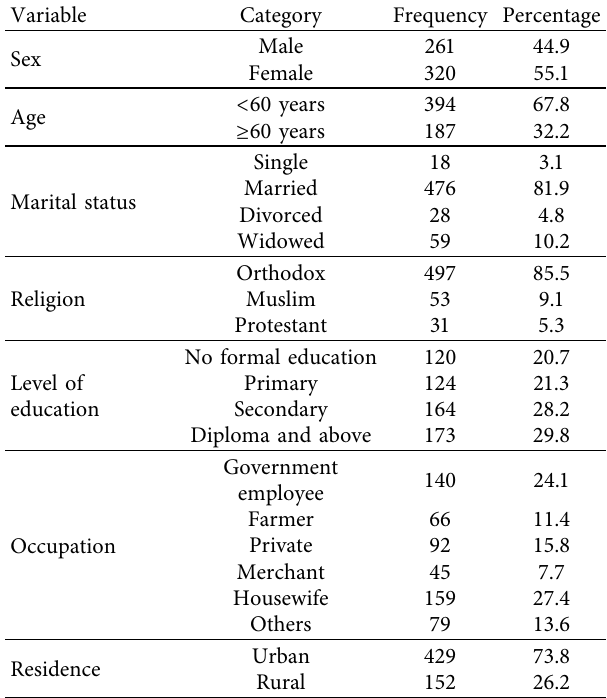
Table 2: Sociodemographic characteristics of hypertensive patients attending at the chronic follow-up clinic at Northwest Ethiopia referral hospitals,